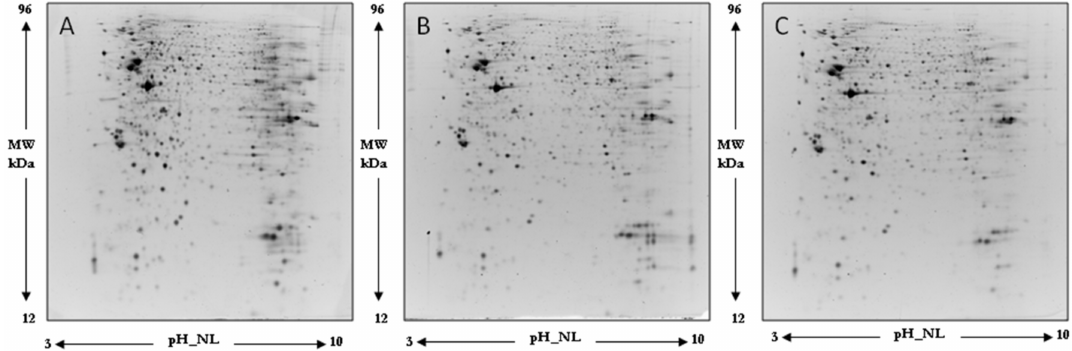
Figure 4. Representative 2D gel map of differentiated SH-SY5Y human neuroblastoma cellular protein extracts. ( A ) Control cells; ( B ) H 2 O 2 -treated cells; ( C ) Oleocanthal + H 2 O 2 treated cells. Proteins were separated in a 3–10 nonlinear gradient. Sodium dodecyl sulfate polyacrylamide gel electrophoresis